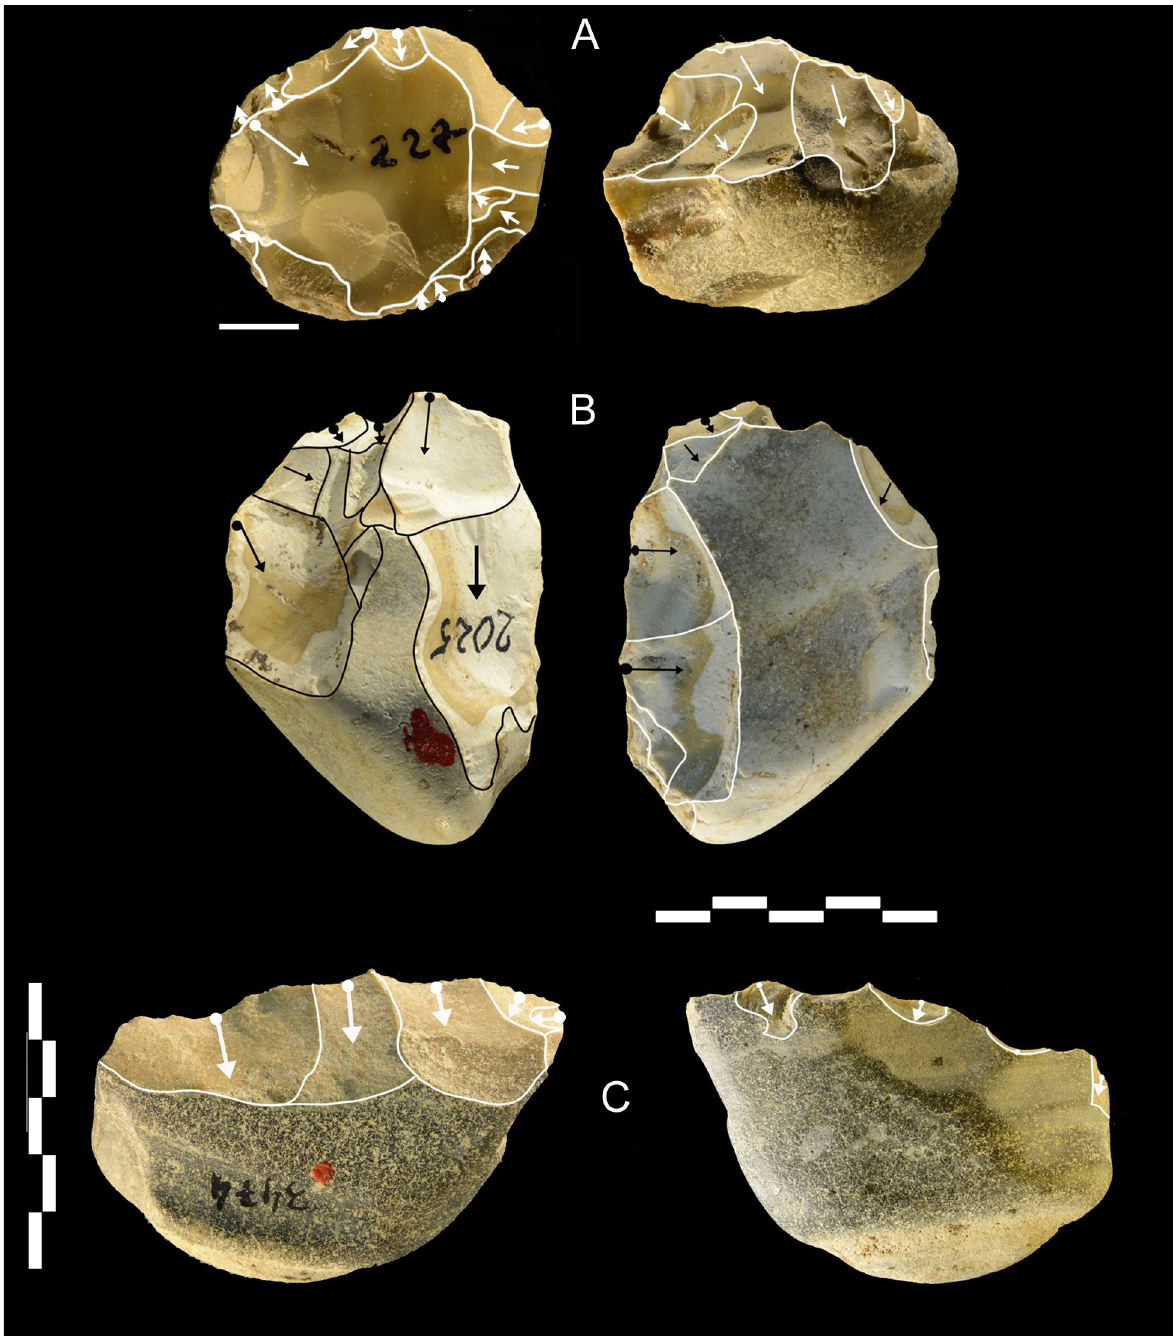
Fig 20. Castel di Guido lithics. Cores, A of flint, B and C of chert. A is centripetal non-Levallois, B is multidirectional and C is unidirectional. Catalogue numbers 227, 2065, 3474. Scale bar of A is 1 cm, of B and C is 5 cm.